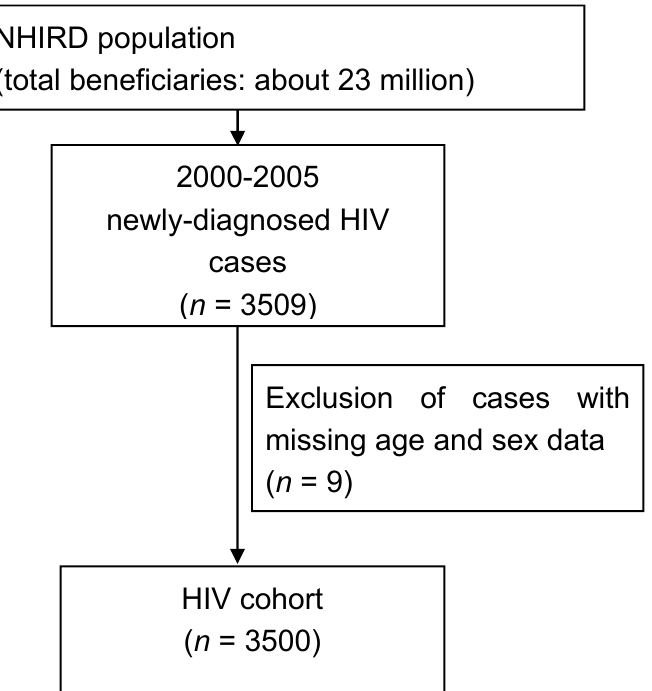
Figure 1. Flow chart of the study population selection.